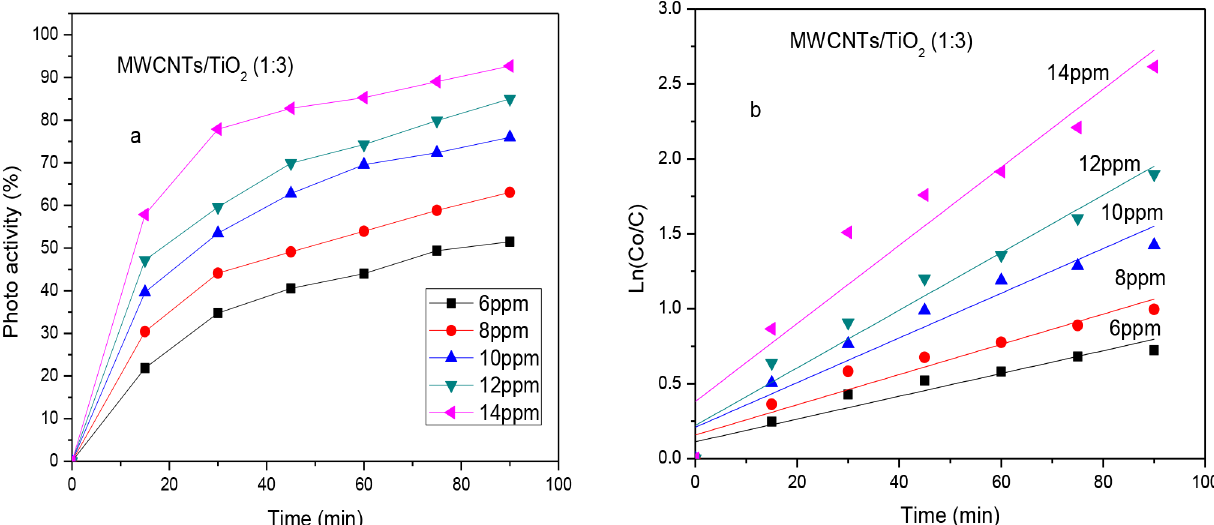
Fig 7. Photodegradation efficiency versus time of irradiation (a), kinetic plots of apparent first-order linear transform ln (C o /C) against time of irradiation (t) (b) under optimised conditions.